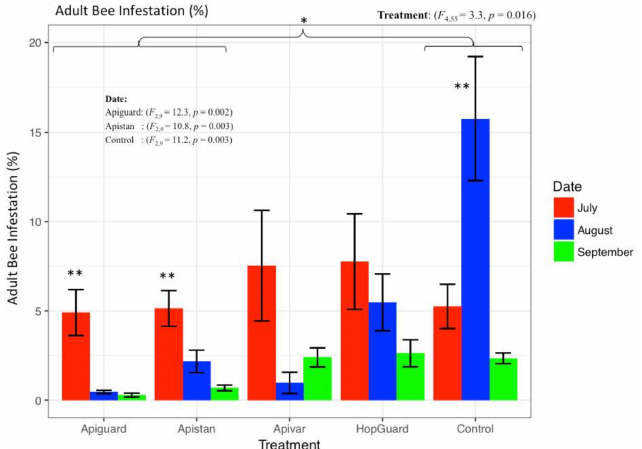
Figure 6. Relative adult bees infestations in three time periods, determined using the sugar shake method. Adult bee infestations before the application of four acaricides, Apiguard ® , Apistan ® , Apivar ® , and HopGuard ® (period before treatments from 31 May–19 July, shown as July in figure) and after treatments (19 July–18 August, shown as August and September in figure, respectively). Denote that colonies of the control group received the acaricide treatment on 18 August and therefore a high Varroa infestation was recorded, as August testing, just before CheckMite ® treatment. CheckMite ® was applied as a final treatment to kill any remaining Varroa mites in all of the colonies. Varroa infestation levels (% ± SE) were calculated based on the relative number of mites remaining on the adult bees in each colony. The horizontal brackets indicate the mean comparison between the control and Apiguard ® and Apistan ® as a single treatment; * p < 0.05; ** p <